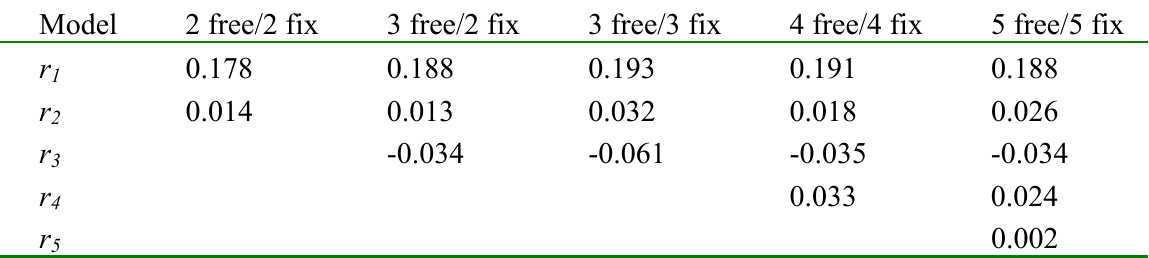
Table I. Rippling parameter r (Å) for the TiN (001) surface computed from periodic GGA DFT calcu- lations and different slab models.